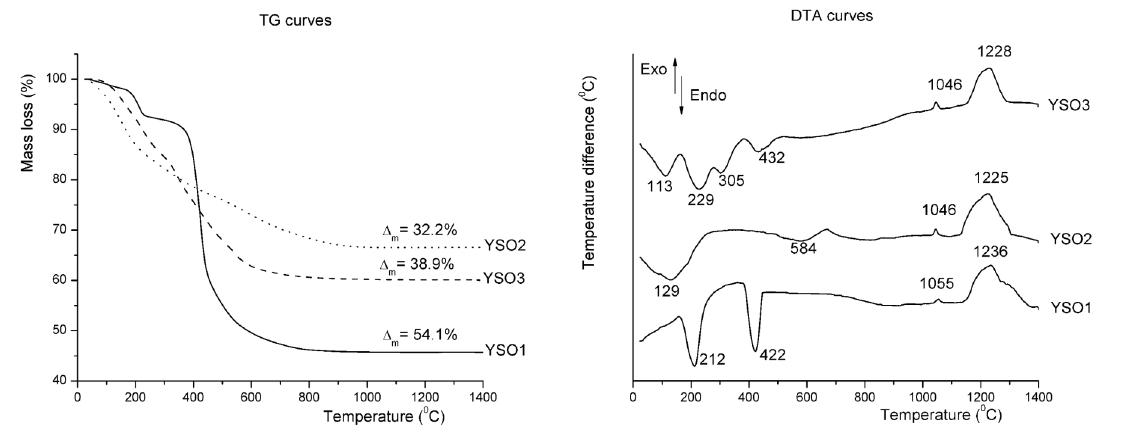
Figure 2. TG and DTA curves of precursors prepared with different precipitating agents: ammonium oxalate (YSO1), ammonium carbonate (YSO2) and urea